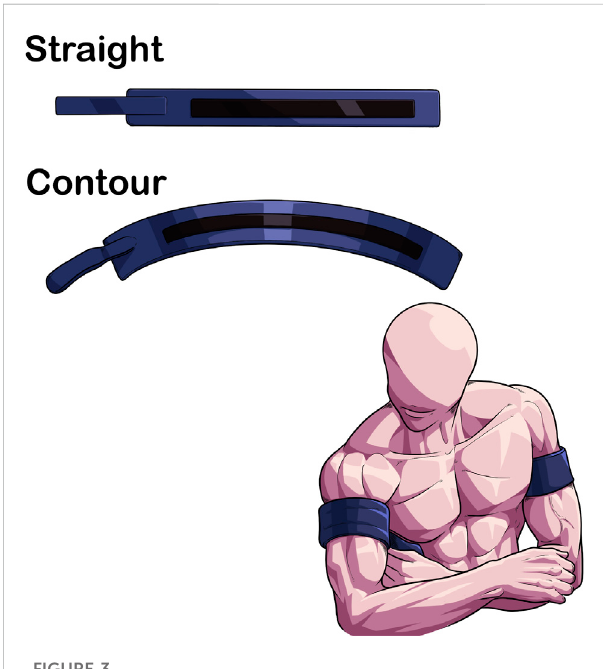
FIGURE 3 Differences in limb fi t between contoured and straight BFR cuffs. contourcuffsprovideamoresecure fi tduetotheconicalshapeofthe limb compared to a straight cuff. This may enhance the safety pro fi le of BFR exercise.